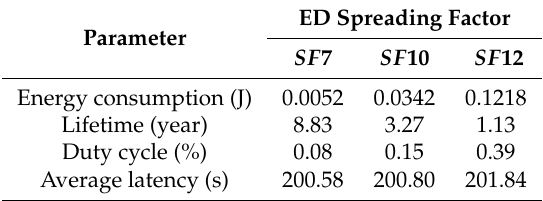
Table 9. Energy consumption, duty cycle and average latency for